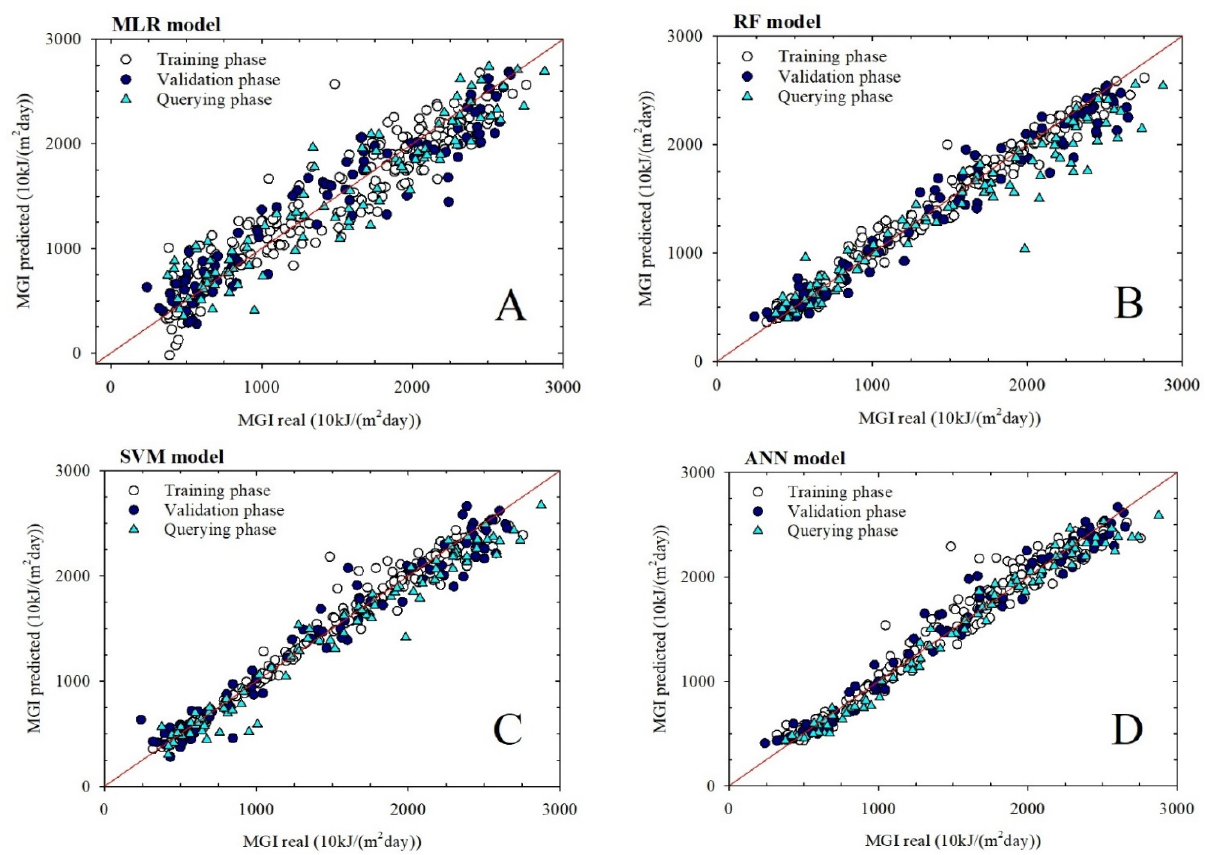
Figure 2. Graphical representation for the real and modelled values of MGI during the training phase (white dots), validation phase (black dots) and querying phase (turquoise triangles) for each select model: ( A ) multiple linear regression -MLR-, ( B ) random forest -RF-, ( C ) support vector machine -SVM- and ( D ) artificial neural network -ANN-. Redline is the line with slope one.